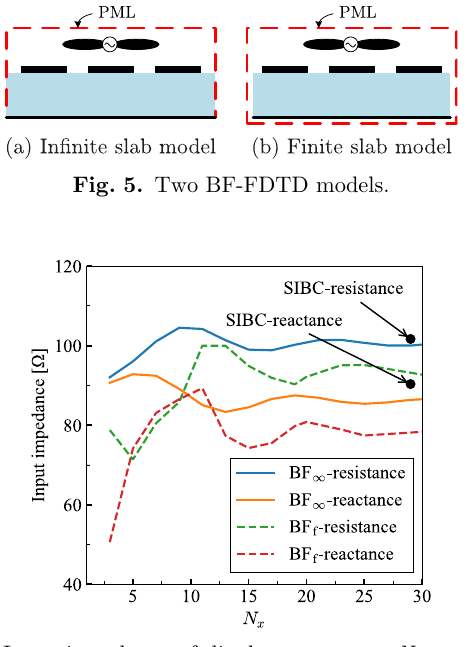
Fig. 7. Input impedance of dipole antenna for h =10 mm, 7.5 mm and 5